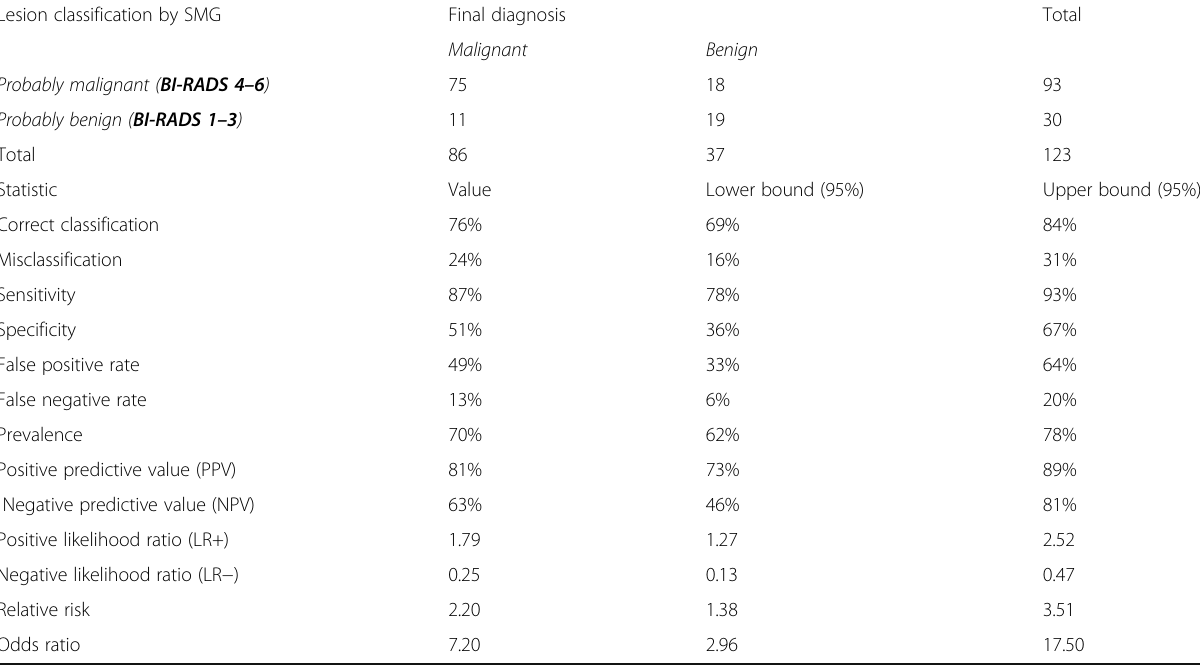
Table 4 Diagnostic accuracy of sonomammography tested in the whole study cohort versus the result of biopsy or follow-up as the gold standard for lesion classification